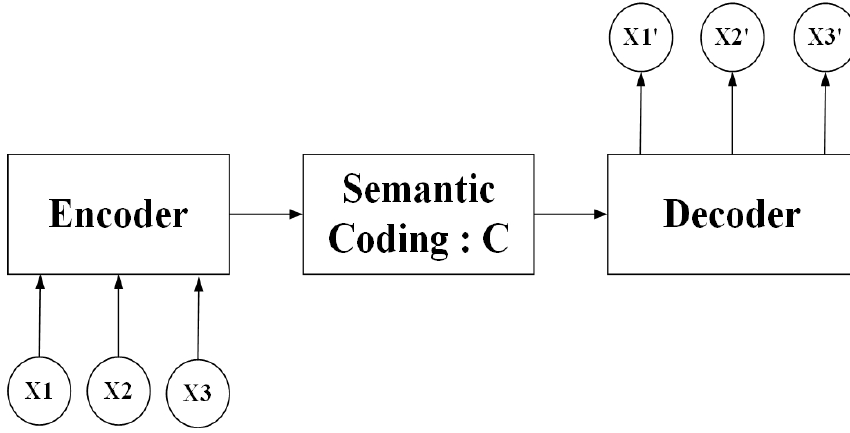
Figure 8. The algorithm framework in